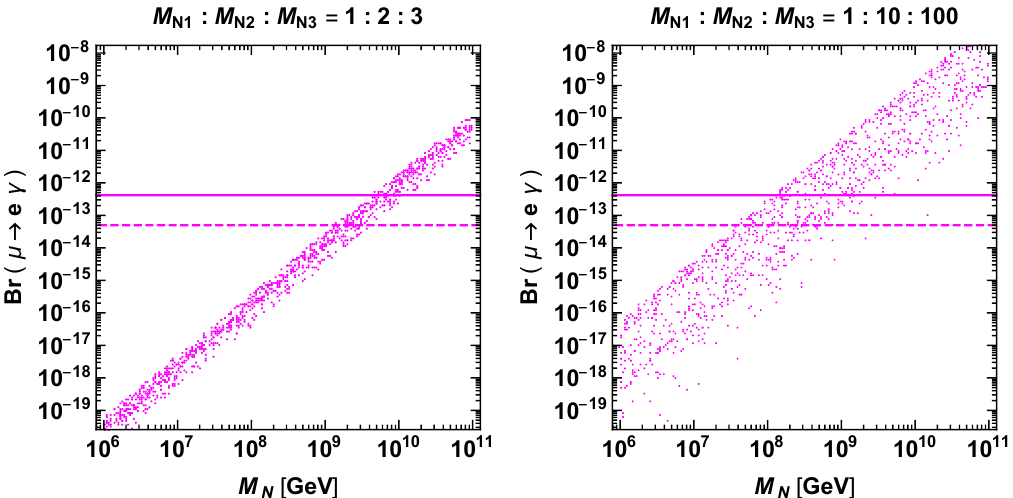
: M N : M N = 1 2 3 = m 2 = − 10 8 GeV 2 H u H d